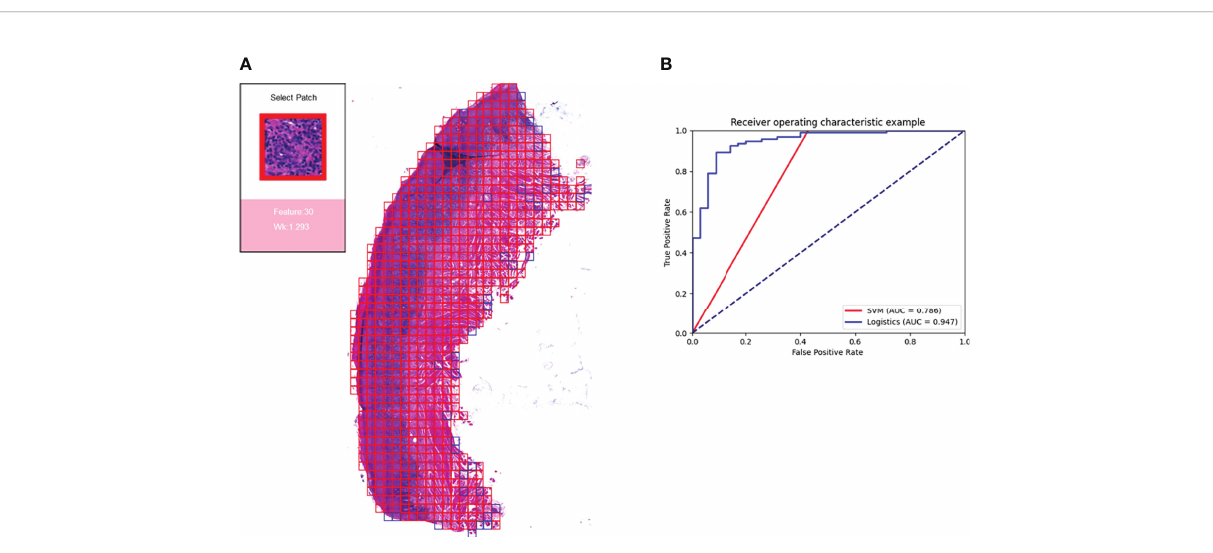
FIGURE 7 | Prediction model and visualization results. We developed a model to predict the ef fi cacy of immunosuppressive treatment based on a logistic regression model. Panel (A) shows the visualization of the prediction results. The patches belonging to positive features were added with red border, and those belonging to negative features are added with blue border. The box on the right shows the magni fi ed morphology of the patch, the feature to which the patch belongs, and the W k value of the category. Panel (B) shows the ROC curves for the SVM model and the logistic regression model. Logistic regression has a higher AUC of 0.947.